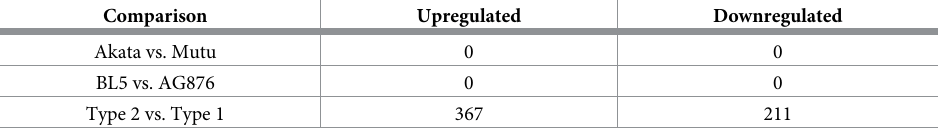
Table 1. Differentially expressed genes measured in bulk RNA-seq. The number of cellular genes showing at least a two-fold change in gene expression is shown when comparing either the different type 1 EBV strain LCLs (Akata